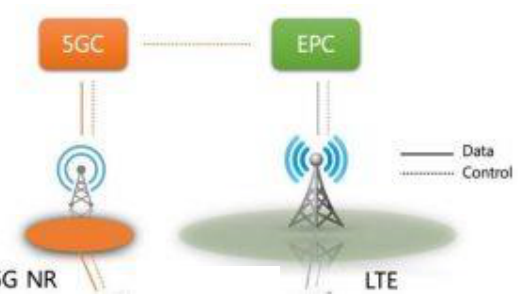
Figure 9. High-level 5GC SA Option 2 interworks with EPC